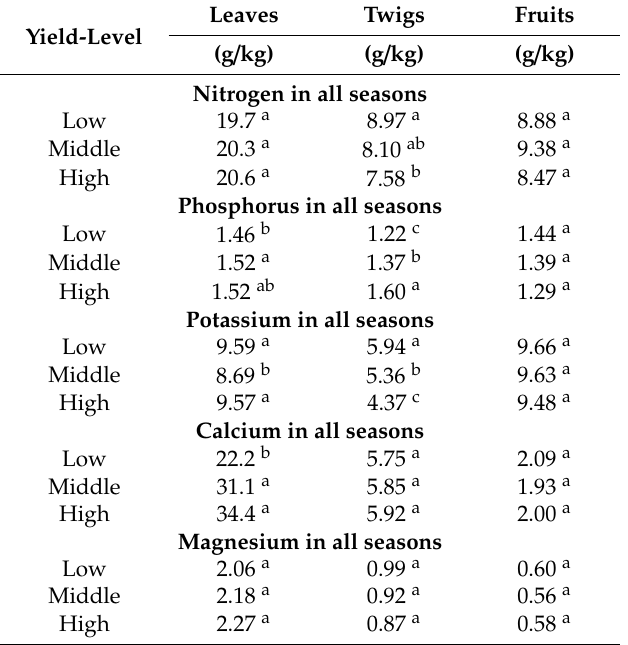
Table 2. Nutrient concentrations of leaves, twigs and fruits under di ff erent yield levels. The di ff erent letters (a–c) in the table represent significant di ff erences ( p < 0.05) among